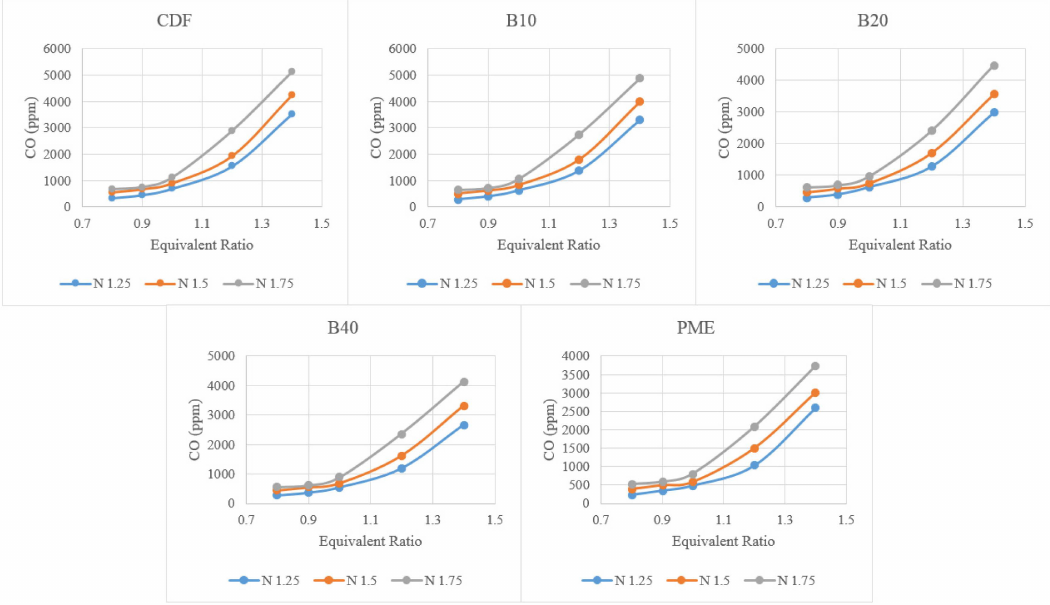
Figure 8. CO emissions at various equivalence